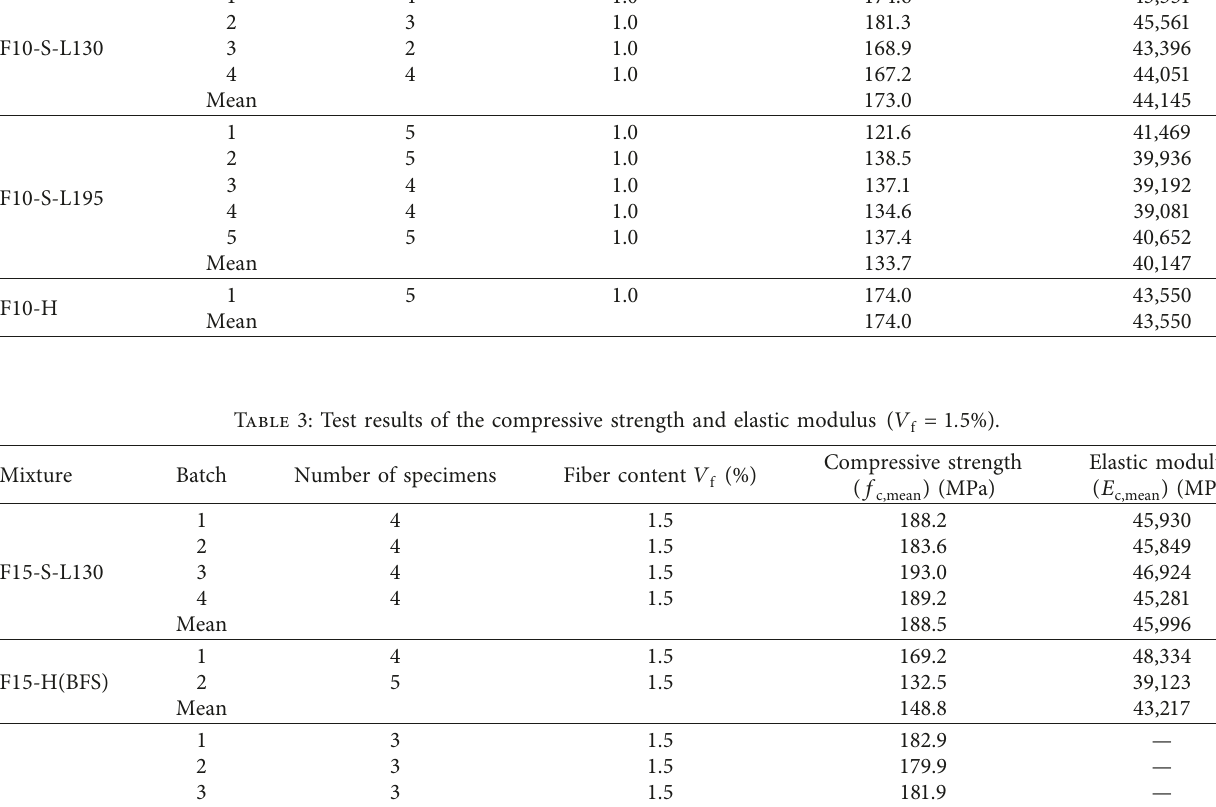
Table 2: Test results of the compressive strength and elastic modulus ( V